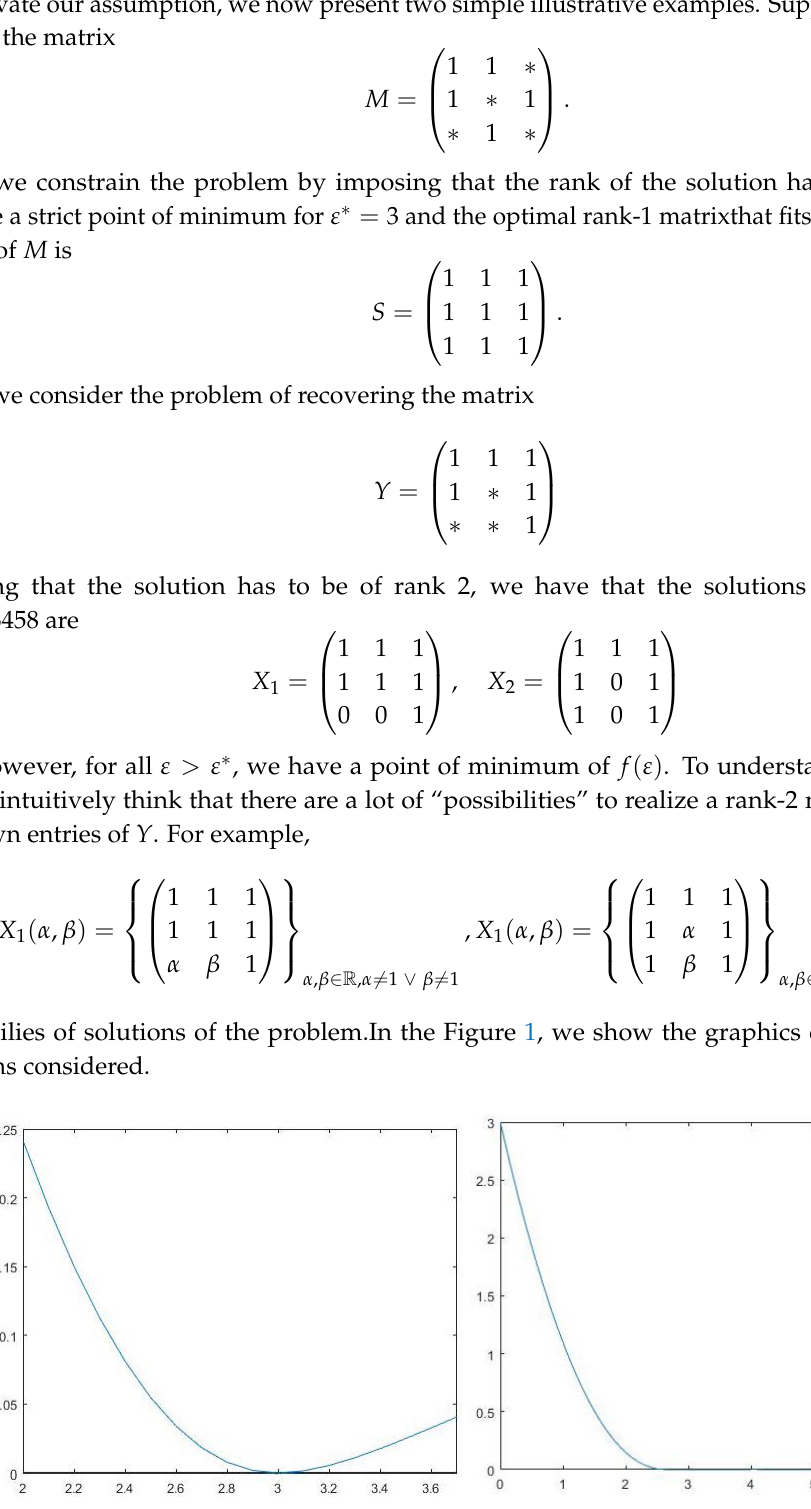
Figure 1. The figure on the left represents the graphic of f ( ε ) when we consider the problem of recovering M by a rank-1 matrix. The figure in the right shows that f ( ε ) is identically equals to zero, when ε ≥ ε ∗ , if we require the rank of the solution to be equal to 2, when we compete Y